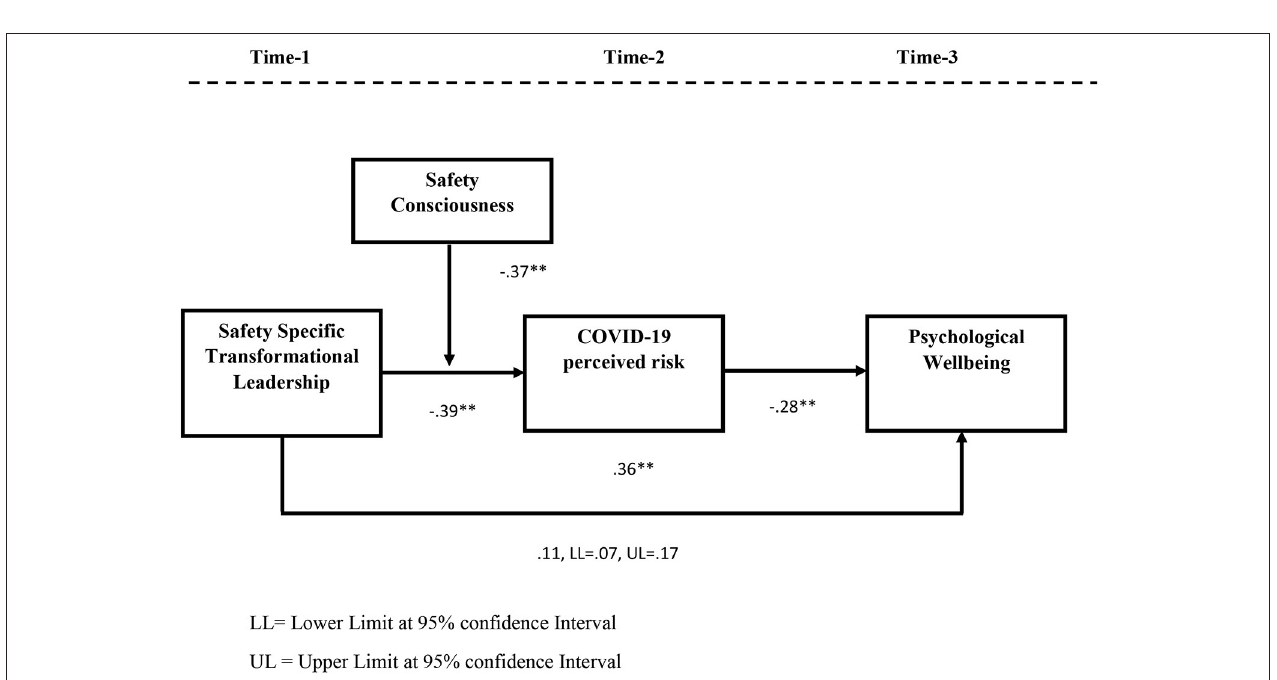
FIGURE 3 | Diagrammatic representation of bootstrapping results for mediation and moderation. LL, Lower Limit at 95% confidence Interval; UL, Upper Limit at 95% confidence Interval. Shows bootstrapping results for direct and indirect effects where safety specific transformational leadership enhances psychological well-being of employees by reducing COVID-19 perceived